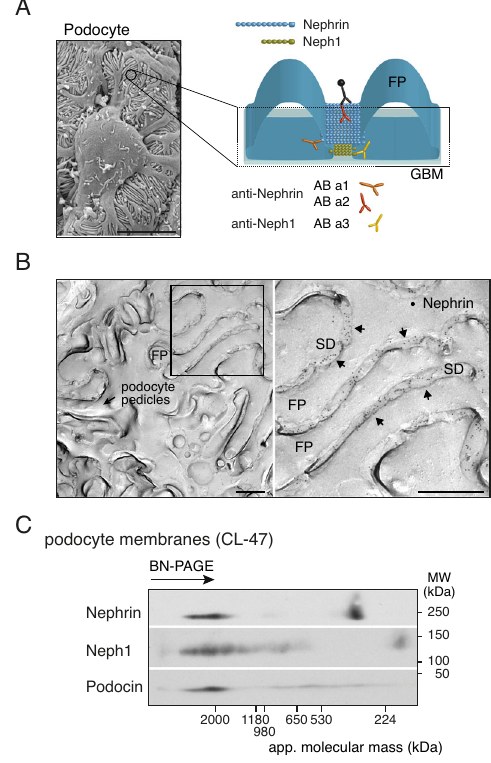
Fig. 1 | Subcellularlocalization and interactome ofNephrin and Neph1 in renal podocytes. A Epitope-localization of the anti-Nephrin/Neph1 ABs used for meAP- MS analysis (further details in Supplementary Fig. 2); inset: Micrograph taken by scanning-EM of glomerular podocytes from rat. Scale bar is 5 µ m. Result is repre- sentative of at least 100 experiments. B Electron micrographs illustrating the dis- tribution of Nephrin molecules labeled by anti-Nephrin AB a2 (and visualized by gold-particle coupledanti-IgG ABs, blackdots) on the extracellular surface (E-face) of freeze-fracture replicas prepared from isolated glomeruli. Image on the right is the frame on the left at expanded scale; FP is foot process, SD is slit-diaphragm. Note that immuno-gold particles for Nephrin are only observed in the slit-area of the SD (arrows). Scale bars are 500nm. Micrographs are representative of at least four experiments. C Two-dimensional gel separation of CL-47 solubilized mem- brane fractions prepared from isolated rat glomeruli, Western-probed with ABs